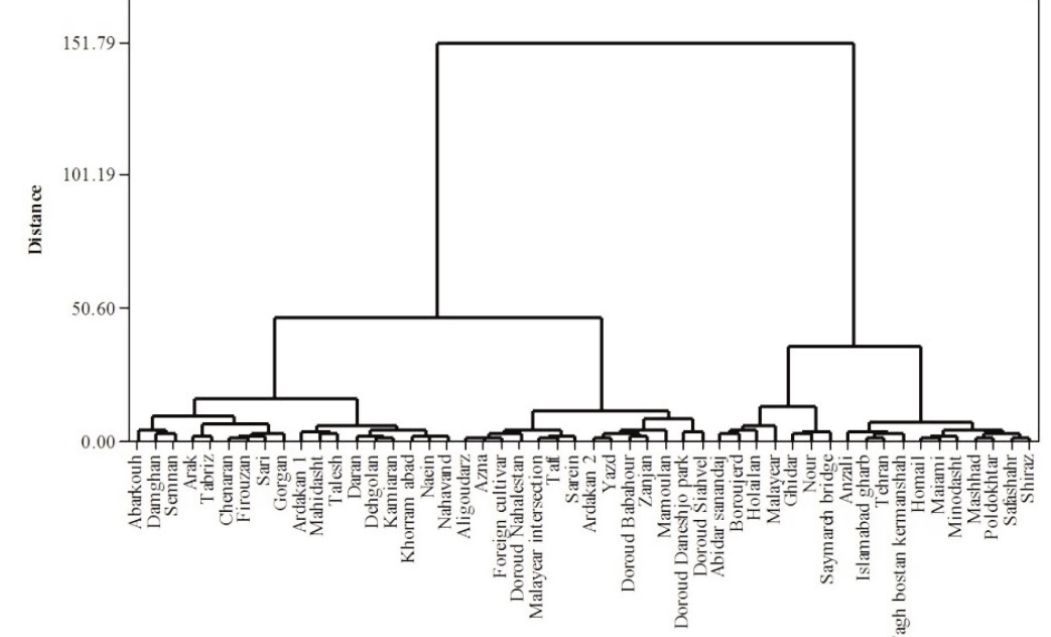
Fig. 2 - Dendrogram of the physiological relationships between 50 accessions of common bermudagrass and control cultivar before cold stress (at 24/17°C day/night cycles).